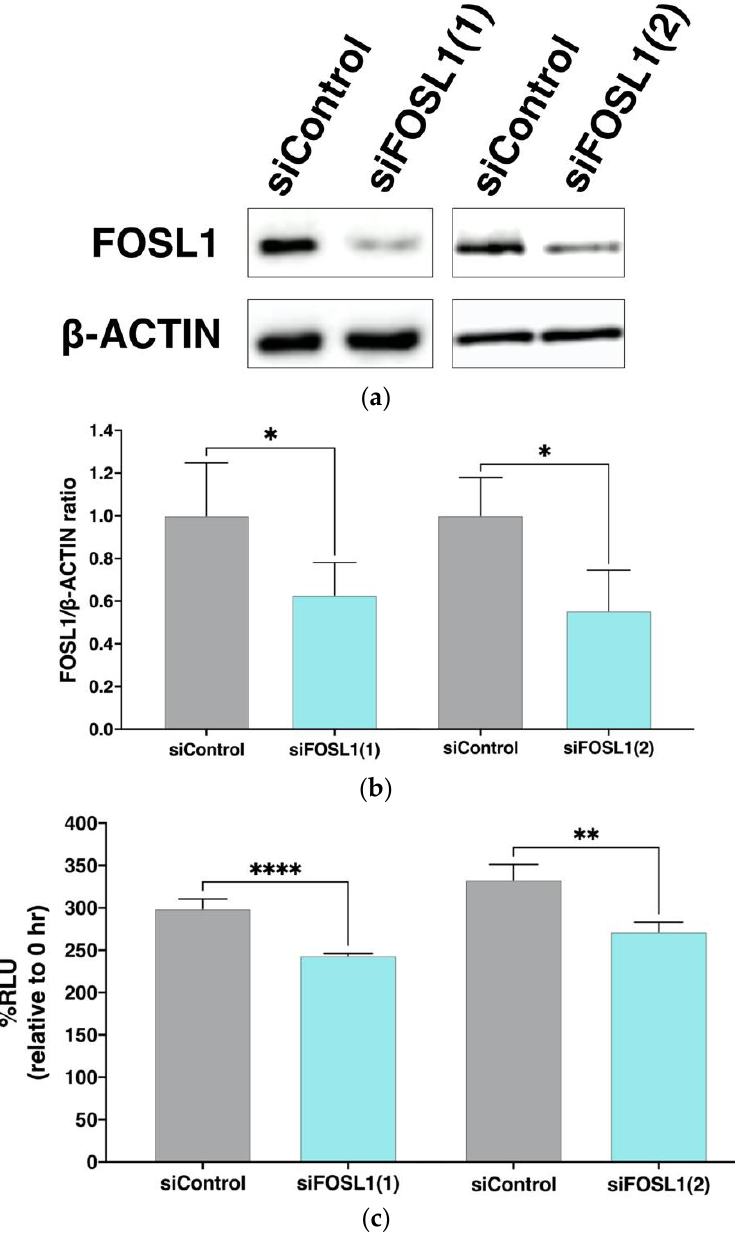
Figure 6. Changes in ADSC viability following siRNA mediated FOSL1 knockdown. ( a ) Expression of the FOSL1 protein using western blot analysis following transfection with two different FOSL1 siRNAs, siFOSL1(1) and siFOSL1(2). ( b ) Six and four independent transfections were performed with siFOSL1(1) and siFOSL1(2), respectively. After 24 h incubation, cell lysates were prepared and analyzed using western blot. FOSL1 expression was normalized to β-ACTIN expression and compared with the siControl group. Data are expressed as the mean ± S.D. * indicates p < 0.05. ( c ) Bar graph showing the percentage of viable ADSCs after a 24 h siRNA transfection. The %RLU at each 0 h is expressed as 100% ( n = 4). Data are expressed as the mean ± S.D. ** p < 0.01, and **** p < 0.0001 are shown.